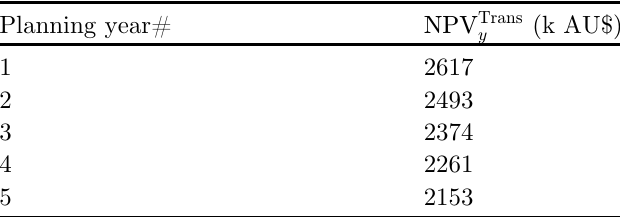
Table 1. The NPV of the distribution transformer for each year during planning period (5 years).